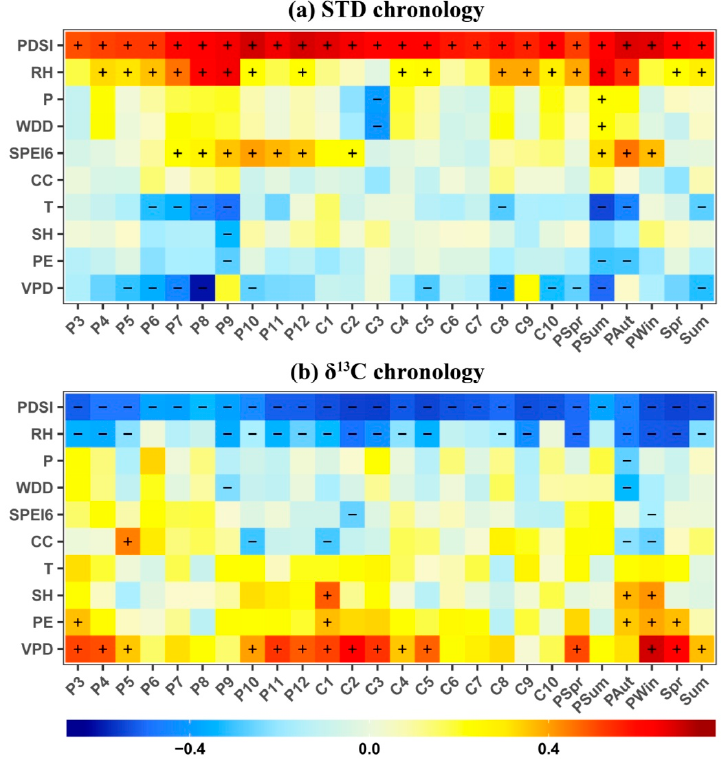
Figure 5. Monthly correlation coefficients of δ 13 C and standard (STD) chronologies to climate variables from 1960 to 2015. ( a ) Correlation coefficients between STD chronology and relative humidity (RH), precipitation (P), wet days duration (WDD), drought index at six-month scales (SPEI06), cloud cover (CC), mean temperature (T), sunshine hours (SH), and vapor pressure deficit (VPD) from previous March (P3) to current October (C10) between 1960 and 2015. Correlations with seasonal variables are also shown. Positive and negative correlations at the 95% significantly levels are highlighted with "+" or "–" respectively. ( b ) Correlations between δ 13 C chronology and the same climatic factors used in ( a ).